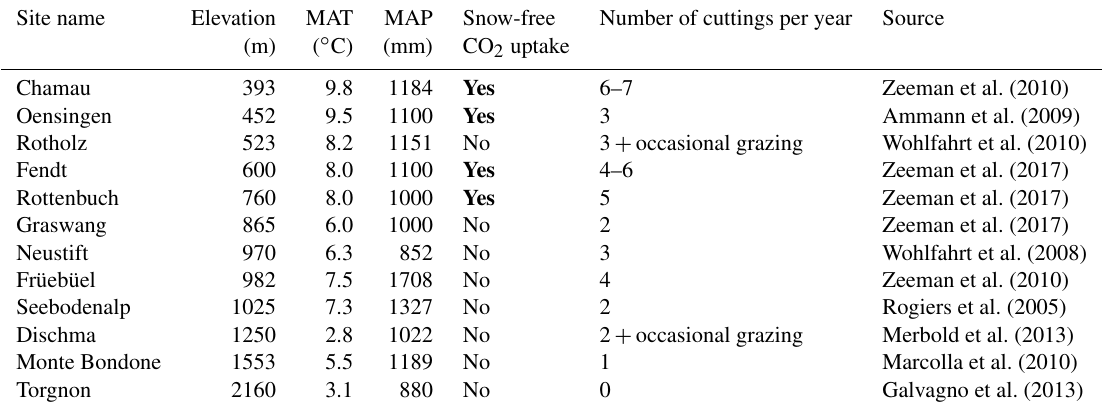
Table 1. Characteristics of past or ongoing CO 2 flux observational sites over grassland ecosystems in European mountains. Snow-free CO 2 uptake (bold font) represents the situation of high negative values of CO 2 flux even during the wintertime (typically from December to